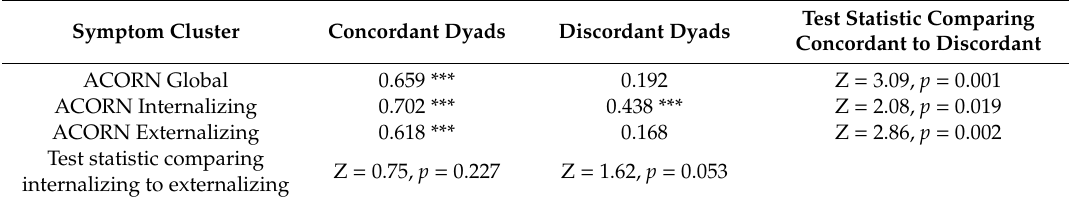
Table 4. Correlations between mother report and youth self-report by primary language concordance and symptom